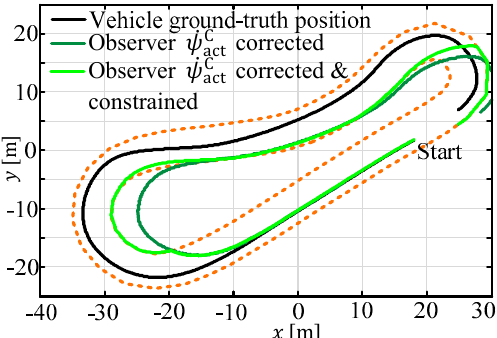
Figure 6. Example path with boundary violation ( Left ) and constraints evaluation ( Right ).